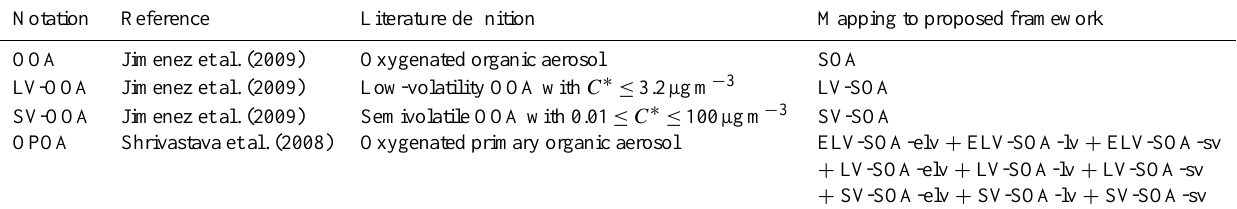
Table 6. Organic aerosol classifications used in the